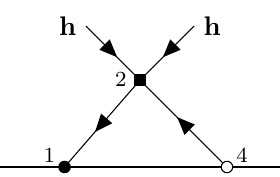
Figure 9 . 1-loop Feynman diagram obtained by contracting the edge connecting the two bulk vertices in subfigure 8a. The square dot represents the combined bulk